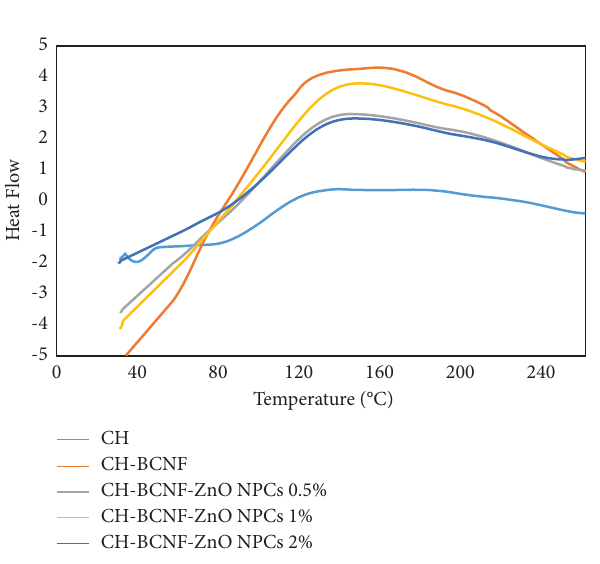
Figure 1: DSC thermograms of diferent flms.